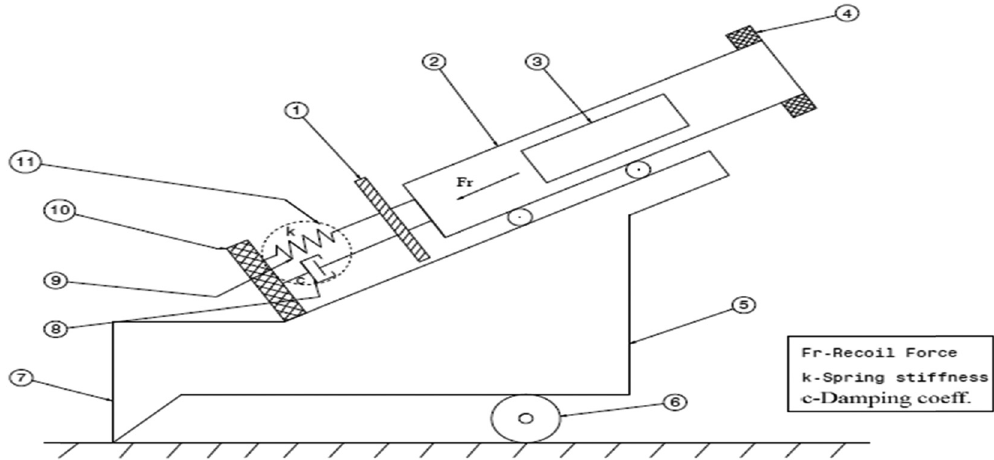
Figure 2: Schematic model of gun recoil system. 1 – Britch, 2 – barrel, 3 – caliber ( projectile ) , 4 – muzzle brake, 5 – gun chasis, 6 – wheel, 7 – trail, 8 – ER damper, 9 – mechanical spring, 10 – gun carriage, and 11 – recoil system.